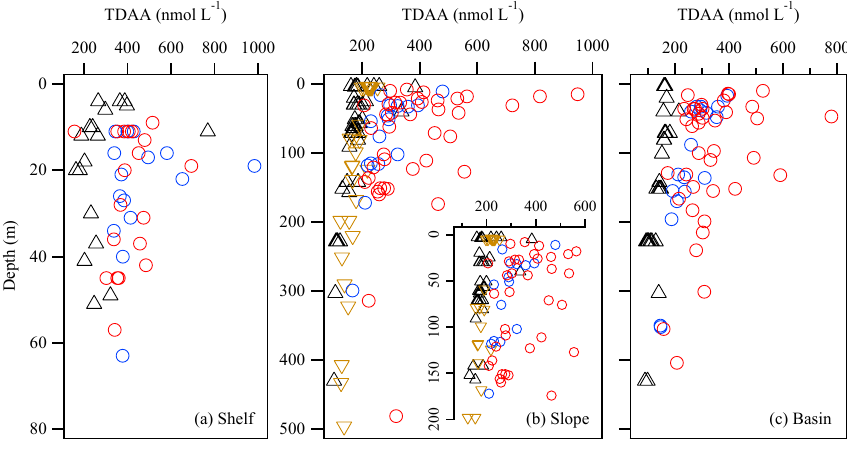
Fig. 4. Concentrations of total dissolved amino acids (TDAA) in (a) shelf, (b) slope, and (c) basin waters of the Chukchi Sea (SBI 2002, SBI 2004) and Beaufort Sea (CFL 2008, MAL